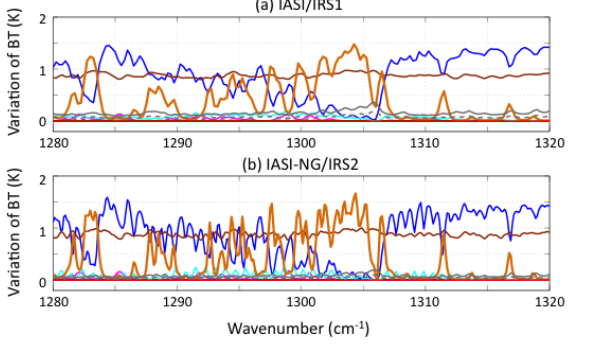
Figure 9. As Fig. 2, for the CH 4 ν 4 absorption band.